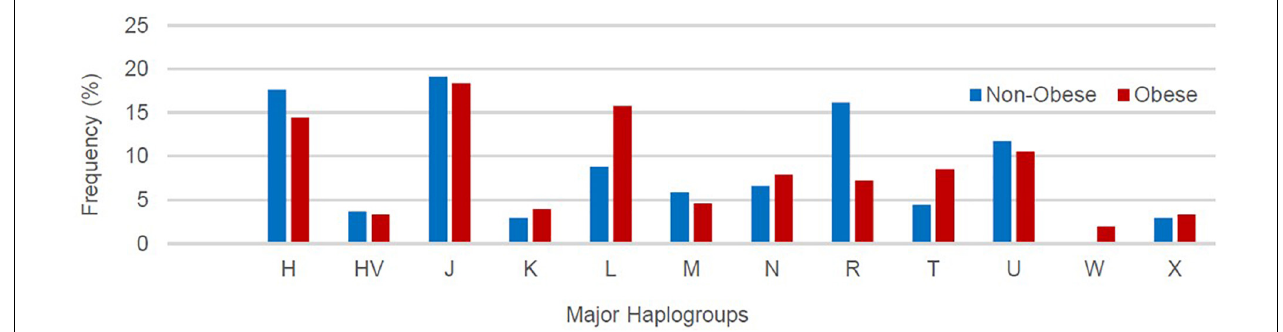
FIGURE 3 | Frequency distribution of major mitochondrial DNA (mtDNA) haplogroups in obese and non-obese